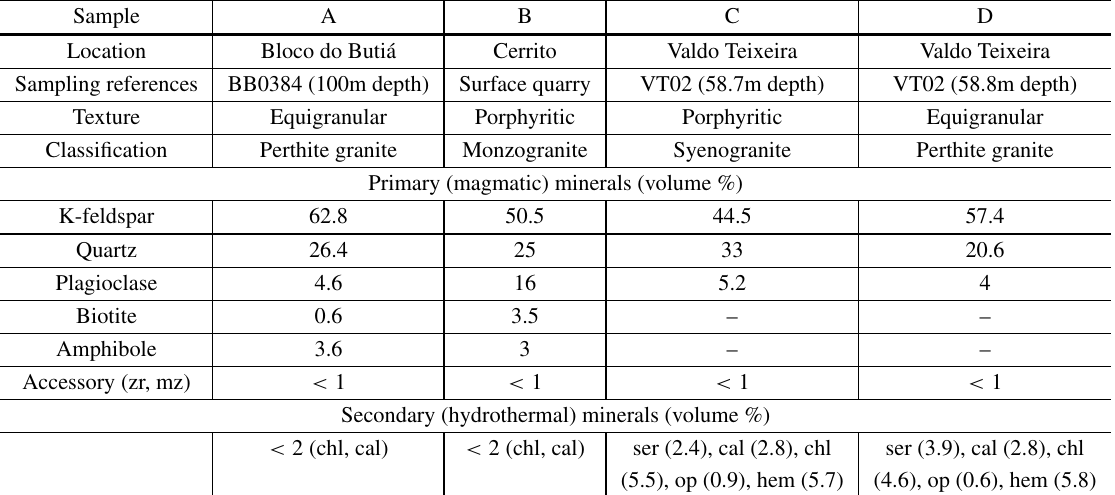
Location, classification, texture features and mineral contents from each sample obtained by point counting (1500 points) of thin sections. Legend: sericite (ser), chl (chlorite), calcite (cal), opaque minerals (op), hematite (hem), zircon (zr) and monazite